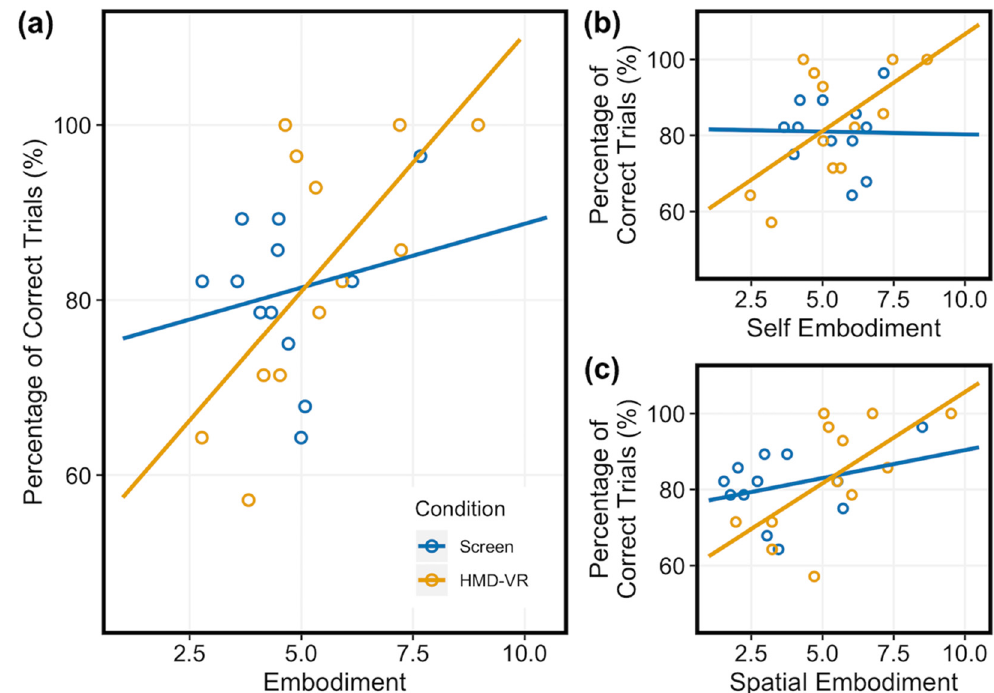
Figure 6. Relationship between subjective experience and neurofeedback performance in Screen (blue) and HMD-VR (yellow). Participants reported their level of Embodiment on a scale from 1 to 10 (Table 1). ( a ) Embodiment: For the HMD-VR condition, embodiment was significantly related to performance. However, for the Screen condition, embodiment did not significantly relate to neurofeedback performance. ( b ) Self Embodiment and ( c ) Spatial Embodiment: For the HMD-VR condition, we found a near significant relationship between the two embodiment sub-features and neurofeedback performance. However, for the Screen condition, we did not find a significant relationship between the two embodiment sub-features and neurofeedback performance.